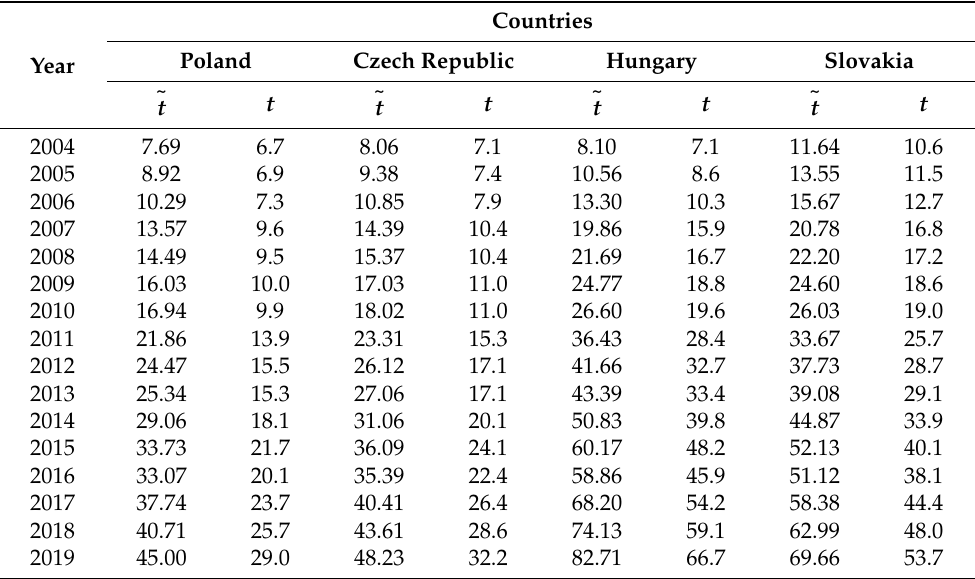
Table 6. The delay of Poland, the Czech Republic, Hungary and Slovakia in relations to Germany III variant.